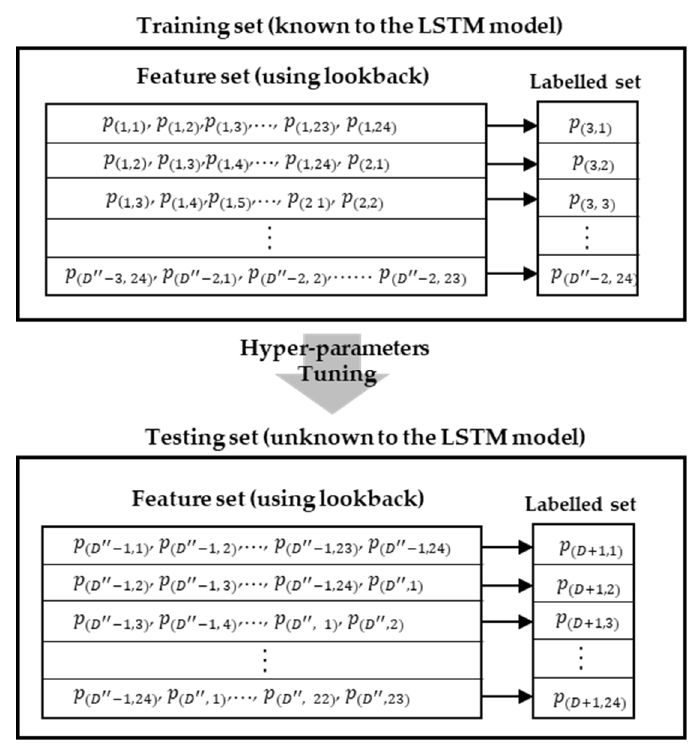
Figure 5. Structure of the training and testing data for the proposed method.